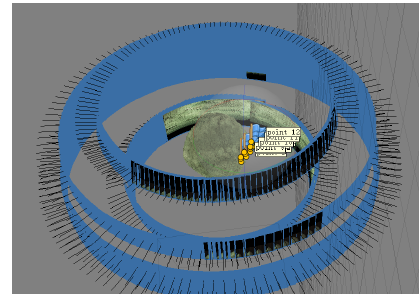
Figure 5. Captured images from multiple orientations